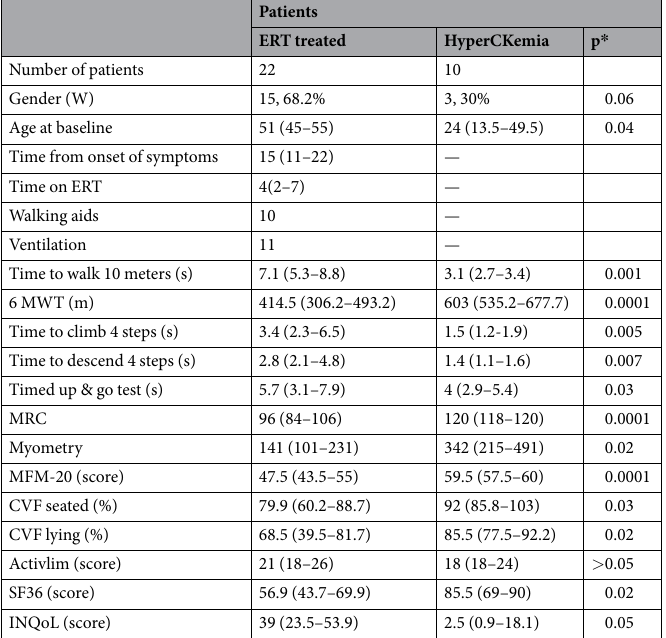
Table 2. Demographic and clinical data of symptomatic and asymptomatic Pompe patients included in the study. Median value and 25 th –75 th percentiles are shown for every variable. S: seconds, m: meters. Mann- Whitney U test was used to compare the groups, except for sex that was studied using Chi